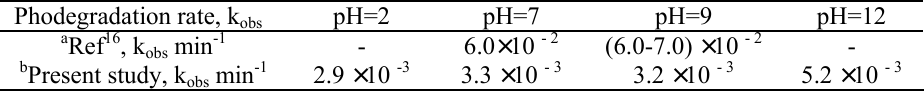
Table 2. A comparison between photodegradation rates of tolonium chloride at different two